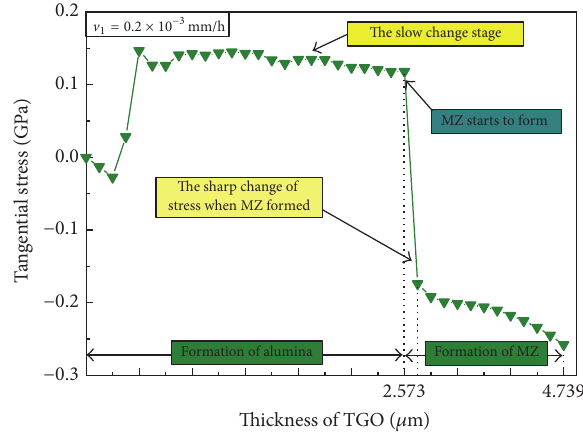
Figure 13: Variation of tangential stress at element number 20857 at the base of the surface groove against the number of thermal cycles when V 1 = 0.2 × 10 −3